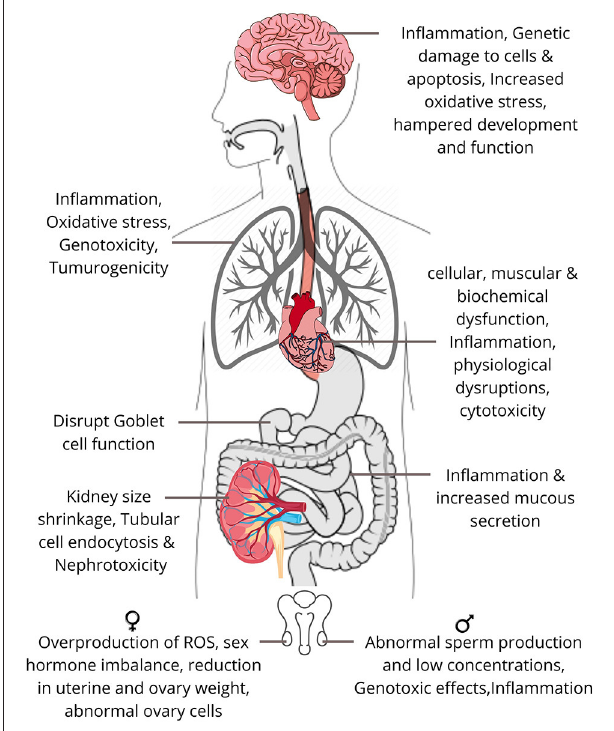
FIGURE 6 | Impact of Nanoparticles on various systems of the human